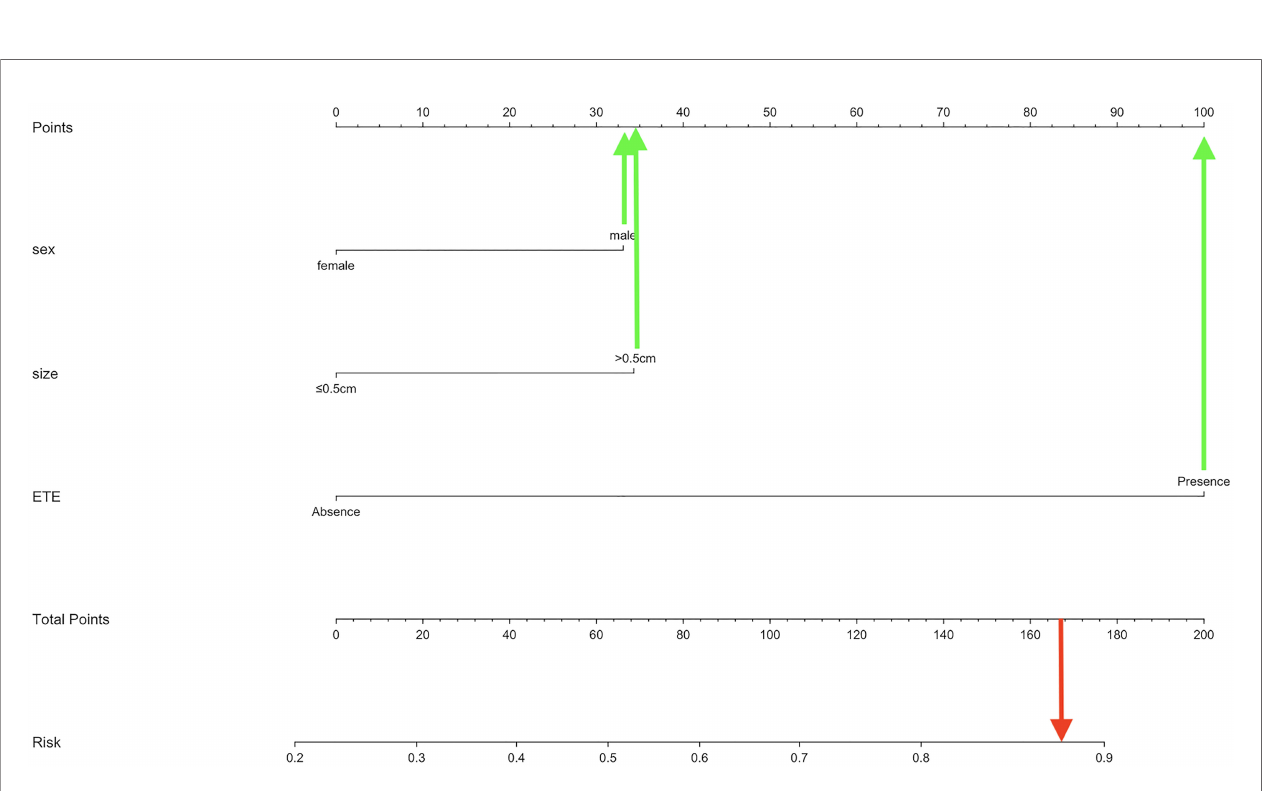
FIGURE 1 | Nomogram for predicting CLNM in patients with